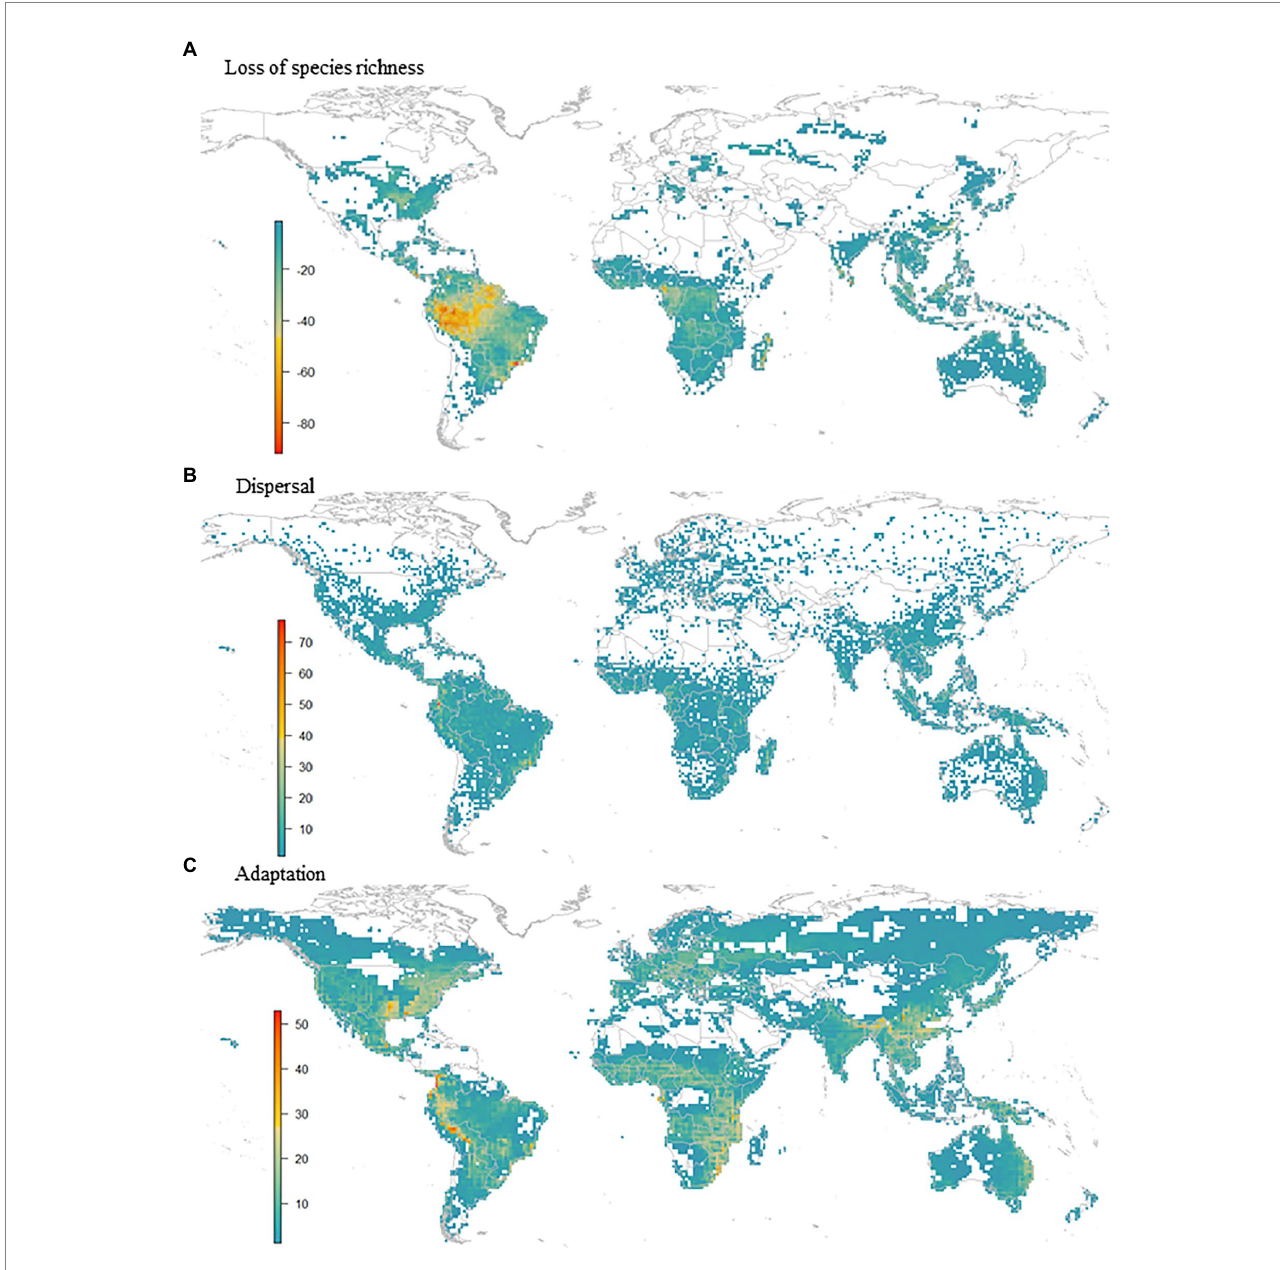
FIGURE 5 Global pattern of (A) loss of species richness, (B) dispersal and (C)